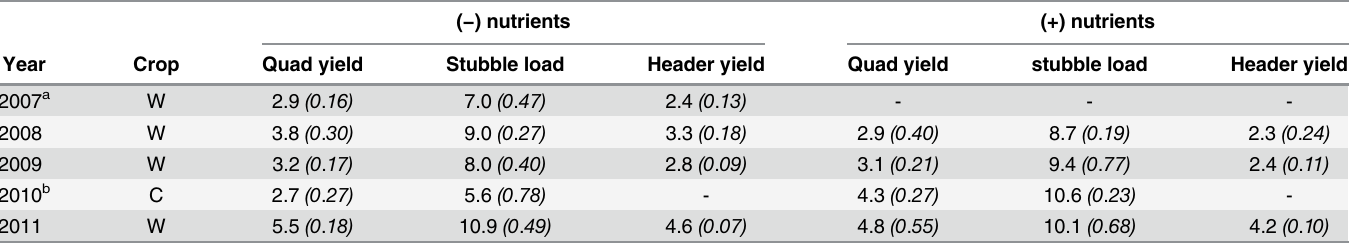
Table 1. Cropping year, crop (wheat, canola), quad yield (t ha -1 ), stubble loads (t ha -1 ), header yield (grain removed from paddock (t ha -1 ) for (+) and ( − ) nutrient treatments at harvest at the Harden field site (data are means and standard errors of the mean, SEM, n = 4